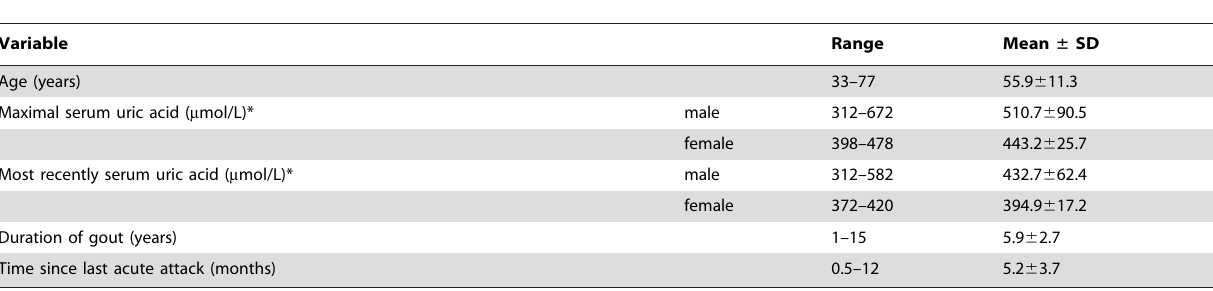
Table 1. Demographic features of patients included in this